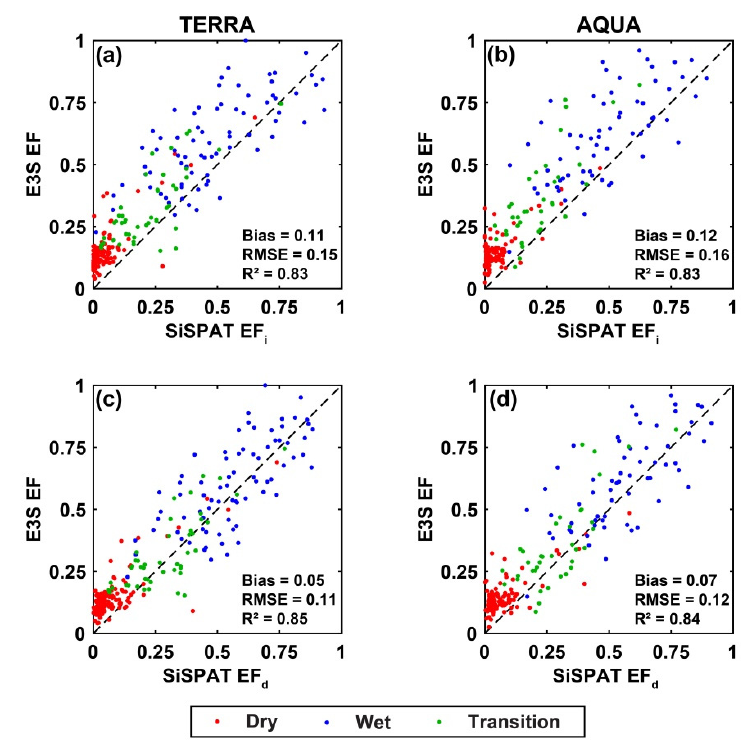
Figure 7. Comparing evaporative fraction EF estimated by E3S with SiSPAT-simulated instantaneous EF ( a , b ) and daily EF d ( c , d ) at TERRA ( a , c ) and AQUA ( b , d ) overpass times. Daily fluxes